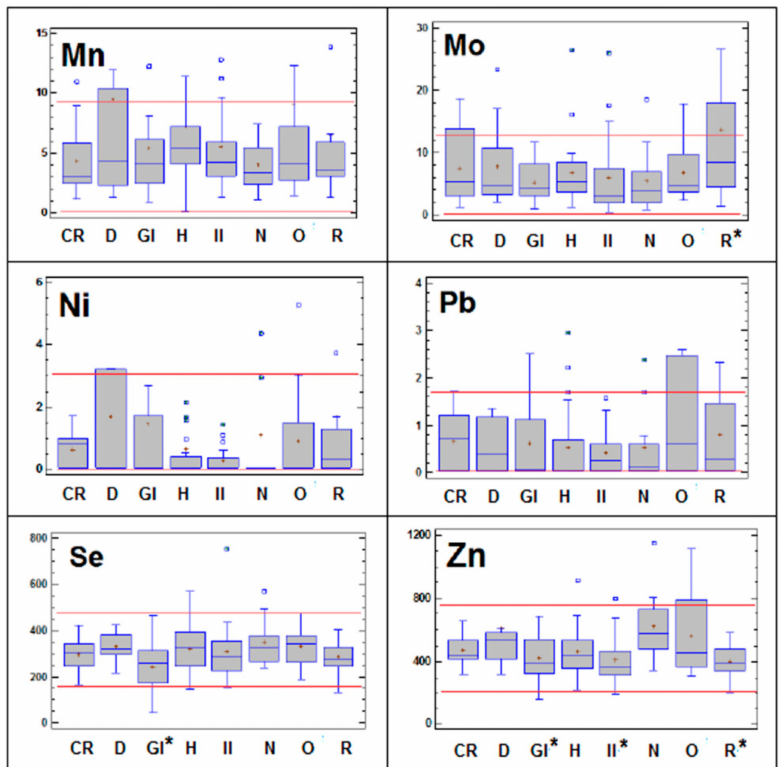
Figure 1. Box-and-whisker plot showing the concentrations of As, Co, Cr, Cu, Fe, Hg, Mn, Mo, Ni, Pb, Se and Zn in the serum of dogs su ff ering from cardiorespiratory (CR), dermatological (D), gastrointestinal (GI), hepatic (H), inflammatory-infection (II), neurological (N), oncological (O) and renal (R) diseases. All concentrations are expressed in µ g L − 1 . The r lines represent the lower reference limit and upper reference limit of the reference interval for each variable obtained from healthy control animals. The horizontal blue line within the box symbolizes the median of the variable; the red cross is the mean value; and the lower and upper boundaries of the box represent the first and third quartiles (thus, the box is the interval covering the middle 50% of the values); whiskers are drawn from the edges of the box to the highest and lowest values (except for values unusually far away from the box). In this case, the outliers, i.e., those points more than 1.5 times the interquartile range (box width) above or below the box, are indicated by blue squares. * Indicates statistically significant di ff erence between the pathological group considered and the control group ( p <